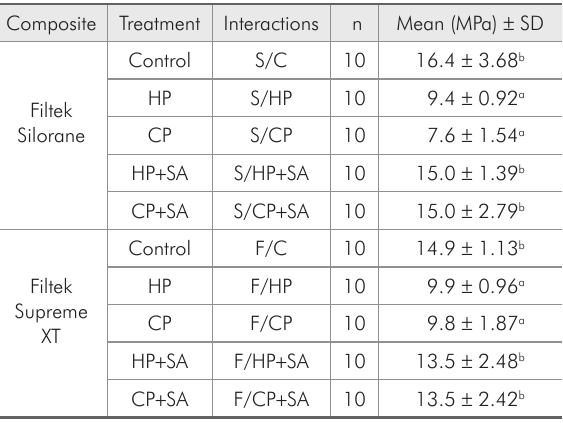
* The different letters indicate dissimilarity of groups ( p <